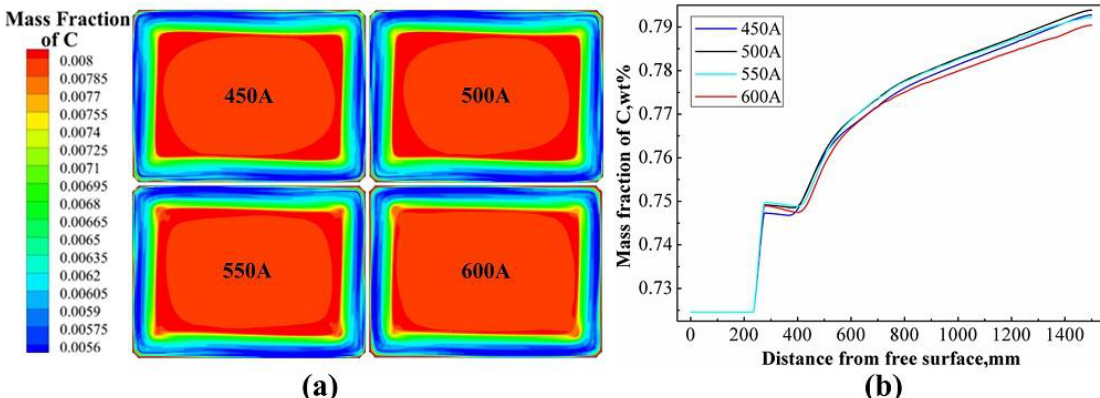
Figure 17. Distribution of element C at computational outlet ( a ) and at centerline ( b ).